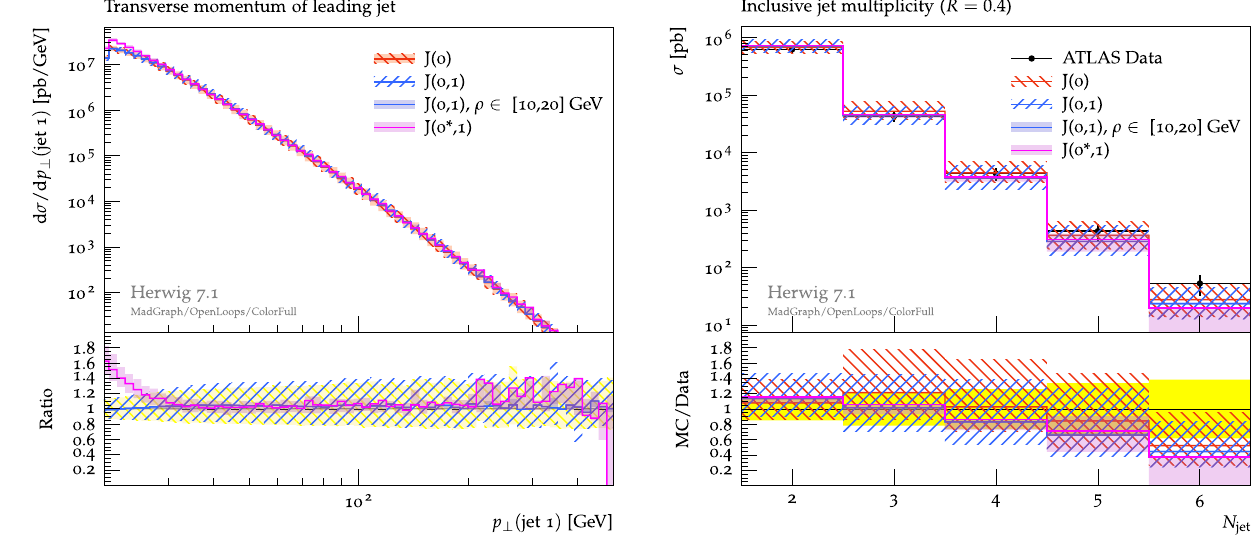
Fig. 28 Comparingmeasuredjetmultiplicities[73]tomergedsamples shows an overshooting of the three-jet contribution of pure showering that is corrected by the merging. However, the measured higher jet multiplicities are included in the uncertainty estimation, the simulation tends to undershoot this